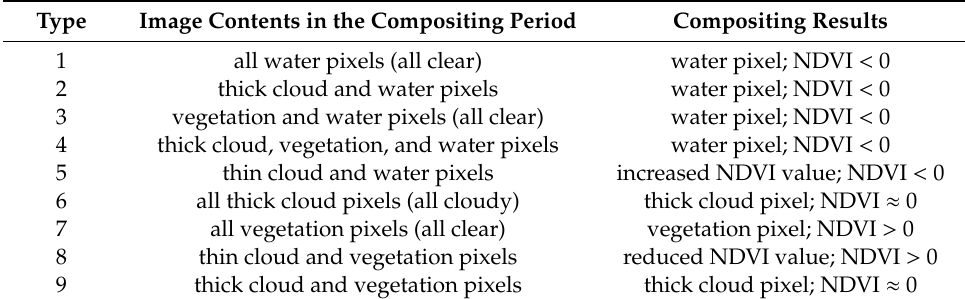
Table 1. Expected compositing results of the NDVI Minimum Value Composite (MinVC)